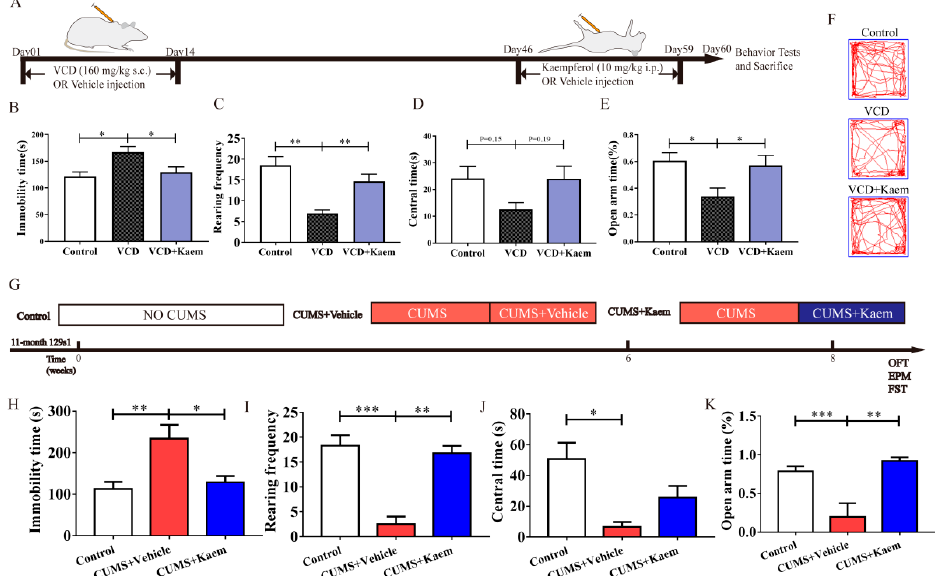
Figure 2. Kaempferol exhibits antidepressant- and anxiolytic-like effects in two mice models of menopausal depression. ( A ) Schematic of the protocol for VCD exposure and kaempferol treatment in mice. ( n = 10–13 per group) ( B ) Immobility time in FST. ( C , D ). Rearing frequency ( C ) and time spent in the central area ( D ) in OFT. ( E ) Percentage of time spent in the open arms in EPM. ( F ) Representative activity traces in OFT. ( G ) Schematic of the protocol for CUMS and kaempferol treatment ( n = 4–5 per group). ( H ) Immobility time in FST. ( I , J ) Rearing frequency ( I ) and time spent in the central area ( J ) in OFT. ( K ) Percentage of time spent in the open arms in EPM. Data are graphed as mean ± SEM, one-way ANOVA analysis with Tukey’s multiple comparisons test or Kruskal–Wallis test with Dunn’s multiple comparisons test: * p < 0.05, ** p < 0.01, *** p < 0.001.